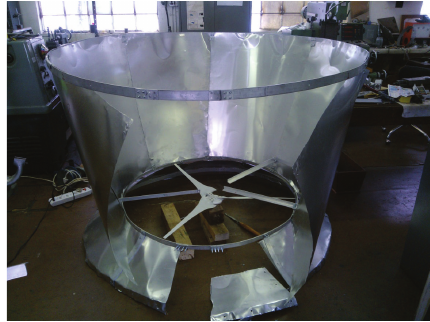
Figure 1: DSWES shroud under construction.